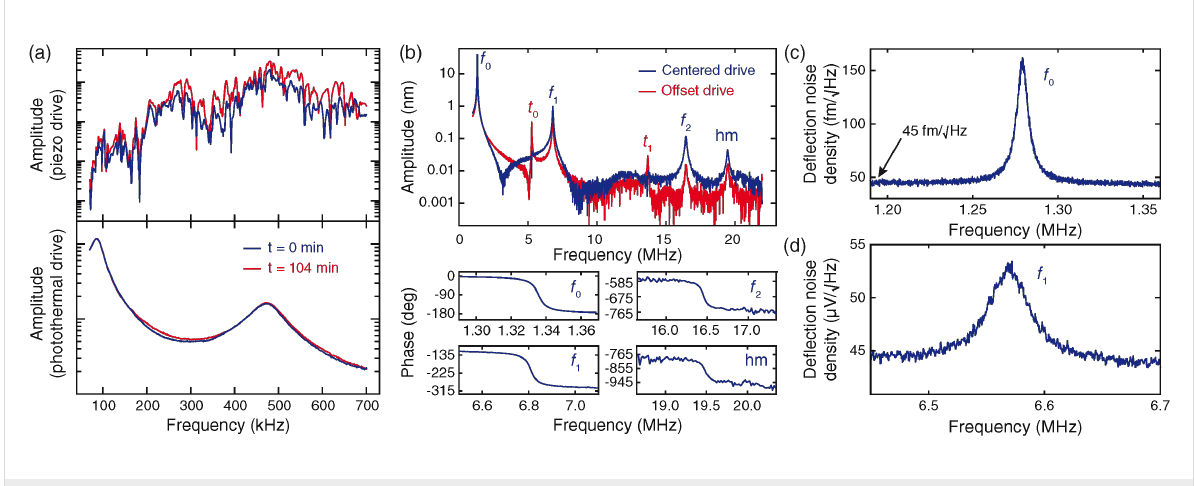
Figure 3: Cantilever drive and deflection readout characterization. a) In contrast to piezo excitation (top curves), photothermal excitation (lower curves) cleanly and consistently drives the first two resonances for more than 100 min. b) The photothermal tunes show resonances up to 19.5 MHz, demonstrating the wide bandwidth with clean phase responses for selected modes. By offsetting the drive laser laterally on a triangular cantilever (Bruker FastScan C), torsional resonances can be excited (red curve). Visible are the first three flexural modes ( f 0 , f 1 and f 2 ), the first two torsional modes ( t 1 and t 2 ), and a complex higher resonant mode (hm). c) Thermal noise peak of the first flexural mode of a FastScan A cantilever, with a base- line noise floor of 45 fm/ . d) Thermal noise peak of the second flexural mode of a FastScan A at 6.6